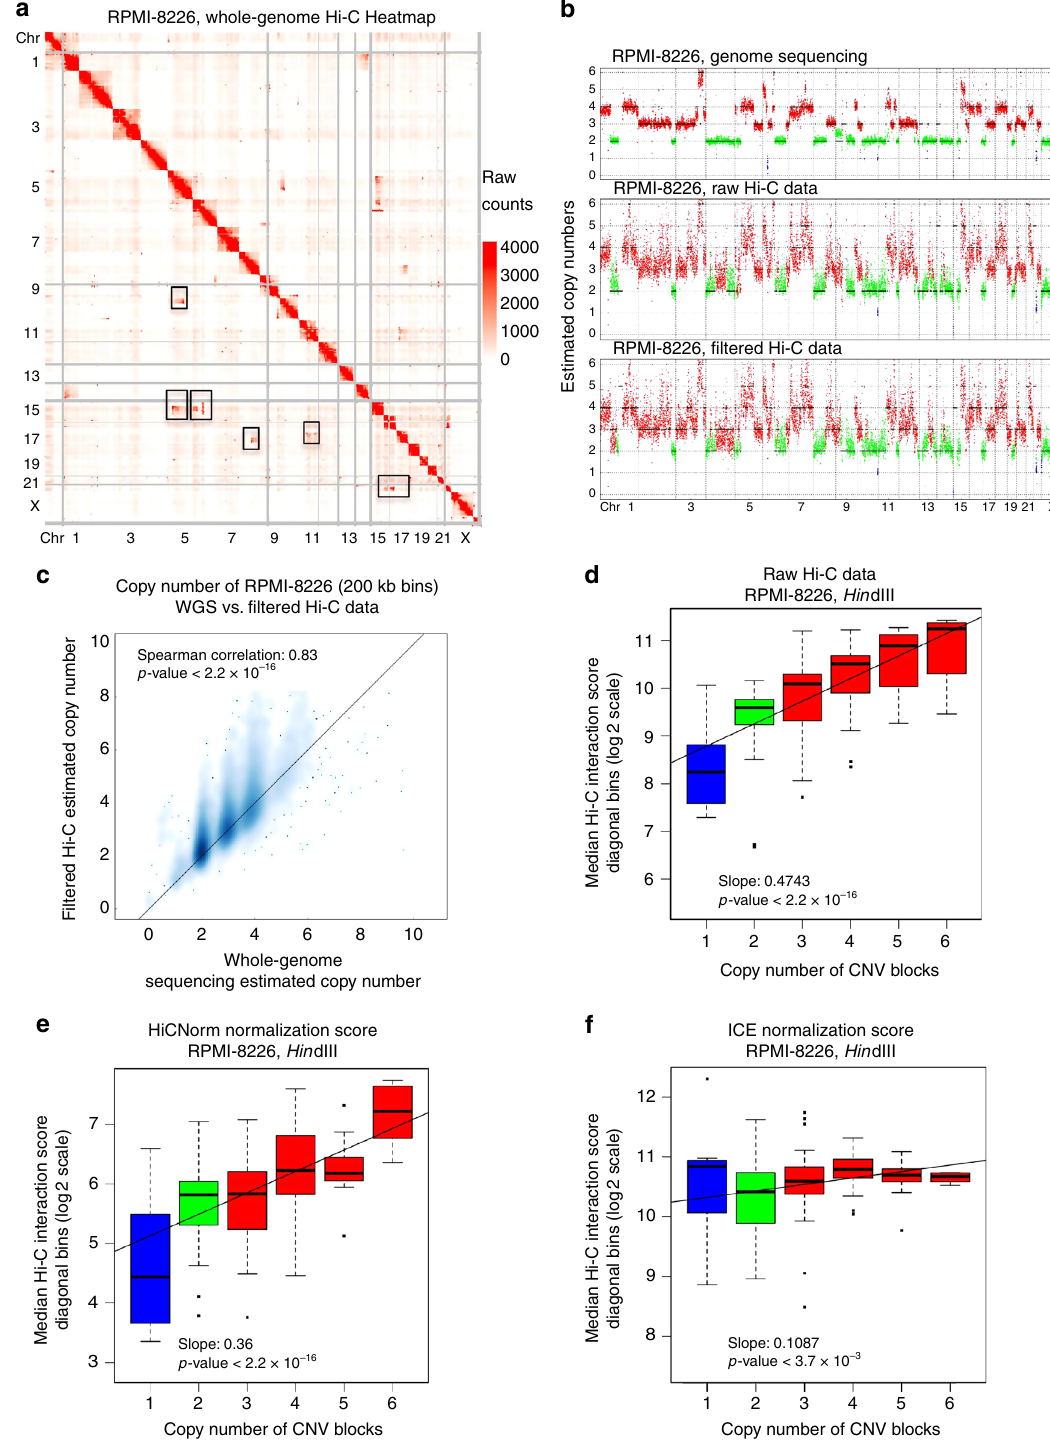
Fig. 1 Correcting copy number variation in cancer Hi-C data. a Whole genome Hi-C interaction matrix of RPMI-8226 cells. Black rectangles indicate inter- chromosomal translocations. b CNVs of RPMI-8226 cells estimated from different sequencing data sets. Methods for fi ltered Hi-C data are described in the Material and Methods. c Scatterplot between the copy numbers estimated from WGS ( x -axis) and fi ltered Hi-C data ( y -axis) shows high similarity. d Median raw Hi-C interaction counts of the diagonal bins in each CNV block vs. the copy number of CNV blocks. A CNV block is de fi ned as a continuous chromosome region with the same estimated copy number from WGS data. e , f Same as d , but the y -axis data are HiCNorm e and ICE-normalized f interaction values. The p -values of fi gures d – f were determined by